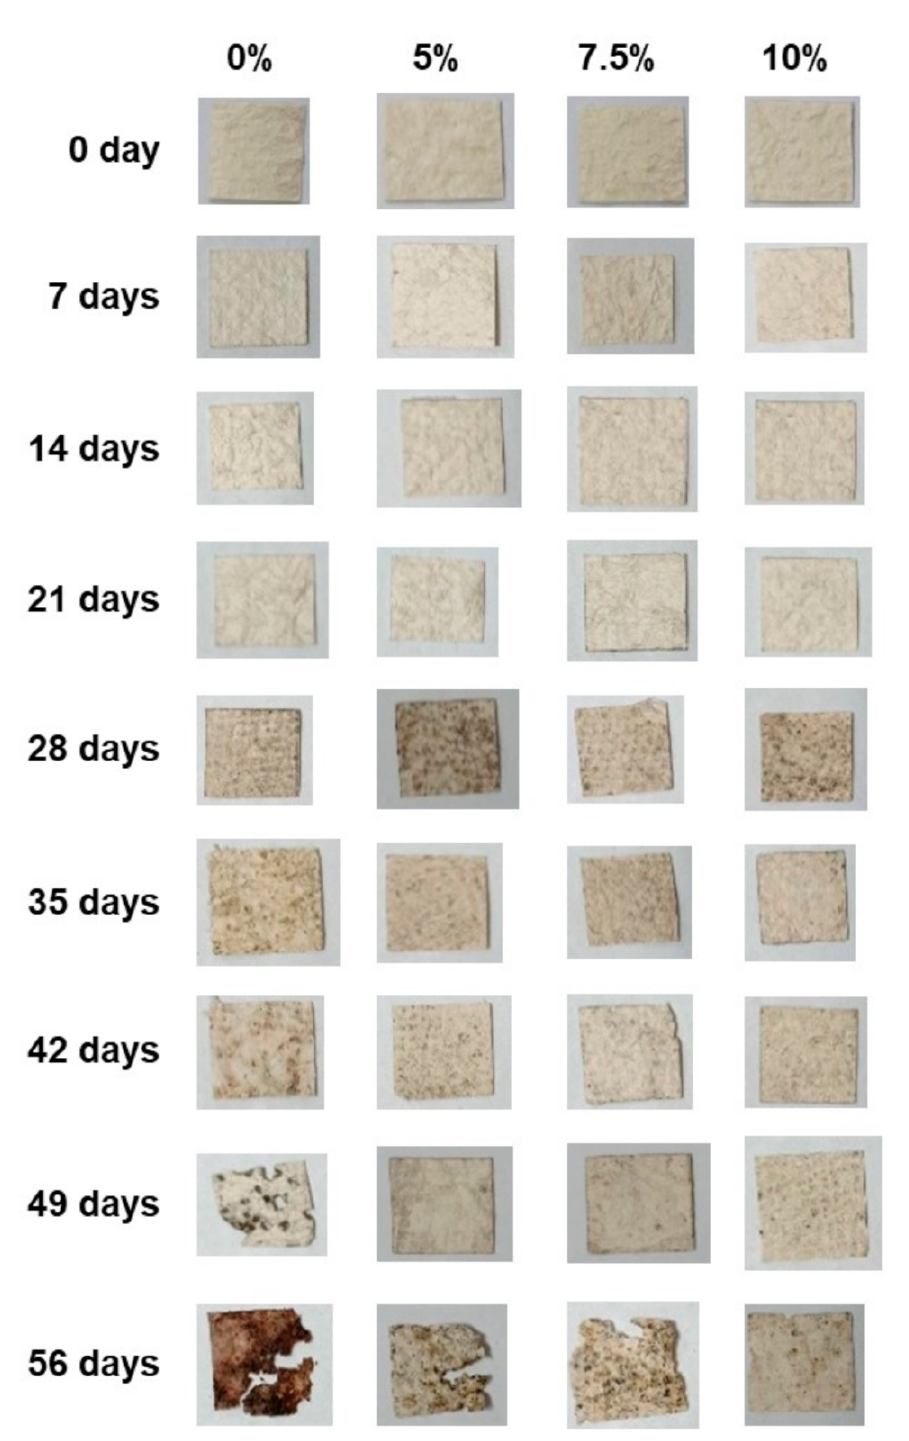
Figure 6. Visual appearance of non-coated and biosynthesized P(3-HB) coated PLFPs (5%, 7.5% and 10% ( w / v )) at different times after burial in